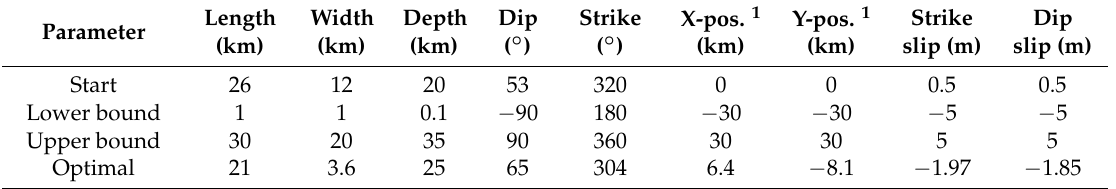
Table 1. Fault parameter intervals and best fit solution resulting from the nonlinear inversion.